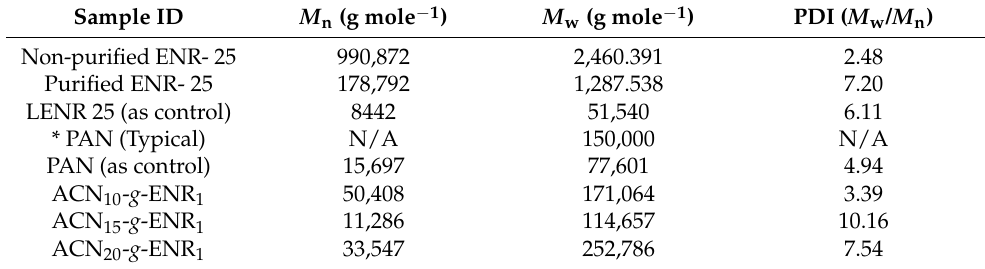
Table 1. Gel permeation chromatography data for PAN, LENR 25, ENR- 25, and ACN- g -ENR products at various mole